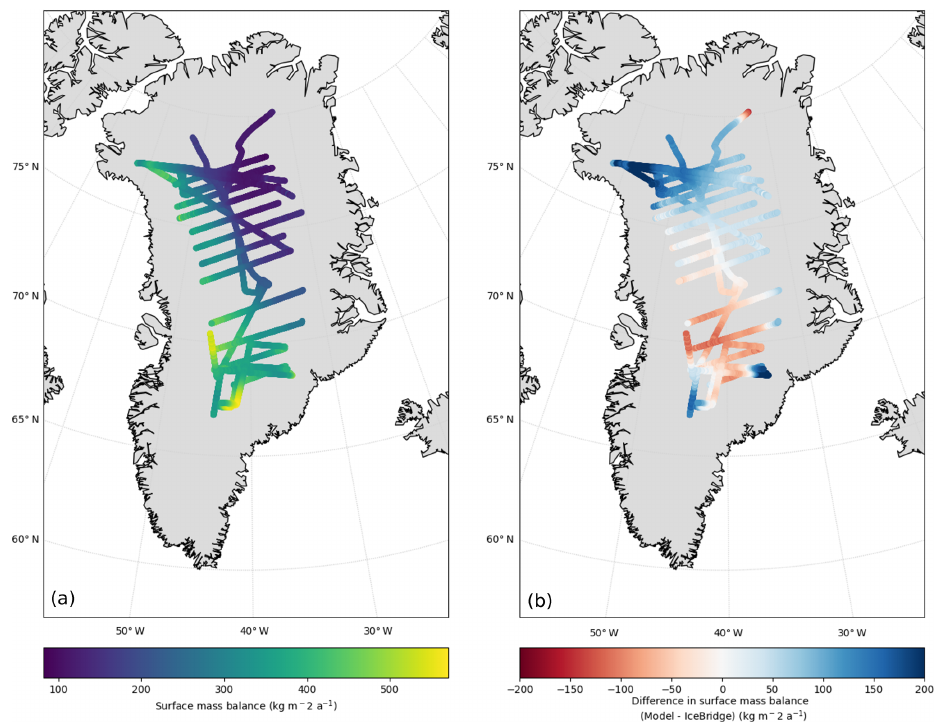
Figure 17. Observed annual surface mass balance of GrIS along IceBridge altimetry transects (a) and the differences between the observa- tions and model along the transects (b)